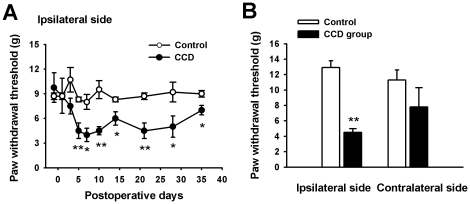
Mechanical allodynia in CCD rats.(A) Time course of changes in the withdrawl threshold of the ipsilateral hindpaw for control (n = 6, open circles) and CCD (n = 4, closed circles) rats. The mechanical threshold for withdrawl of the ipsilateral hindpaw was significantly lower in the chronically compressed rats (* P<0.05 or **P<0.01 compared with the average for the ipsilateral hindpaw of the control group). (B) Average ipsilateral and contralateral paw withdrawl thresholds for the control and CCD groups on the postoperative 5 days.